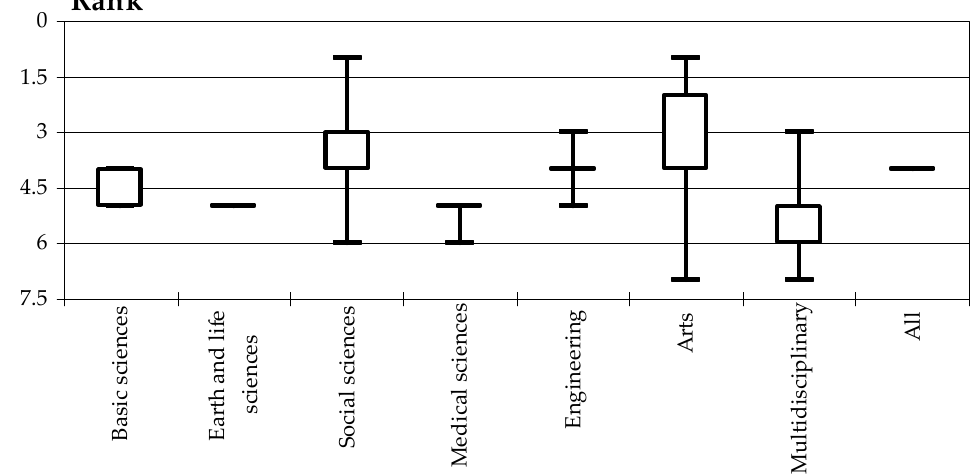
Figure 12. The number of documents published in different fields in Romania during 2010–2018. The figure displays boxplots of the ranks of fields computed for each year separately. Results indicate that the values are in the top part of the ranking for most fields.